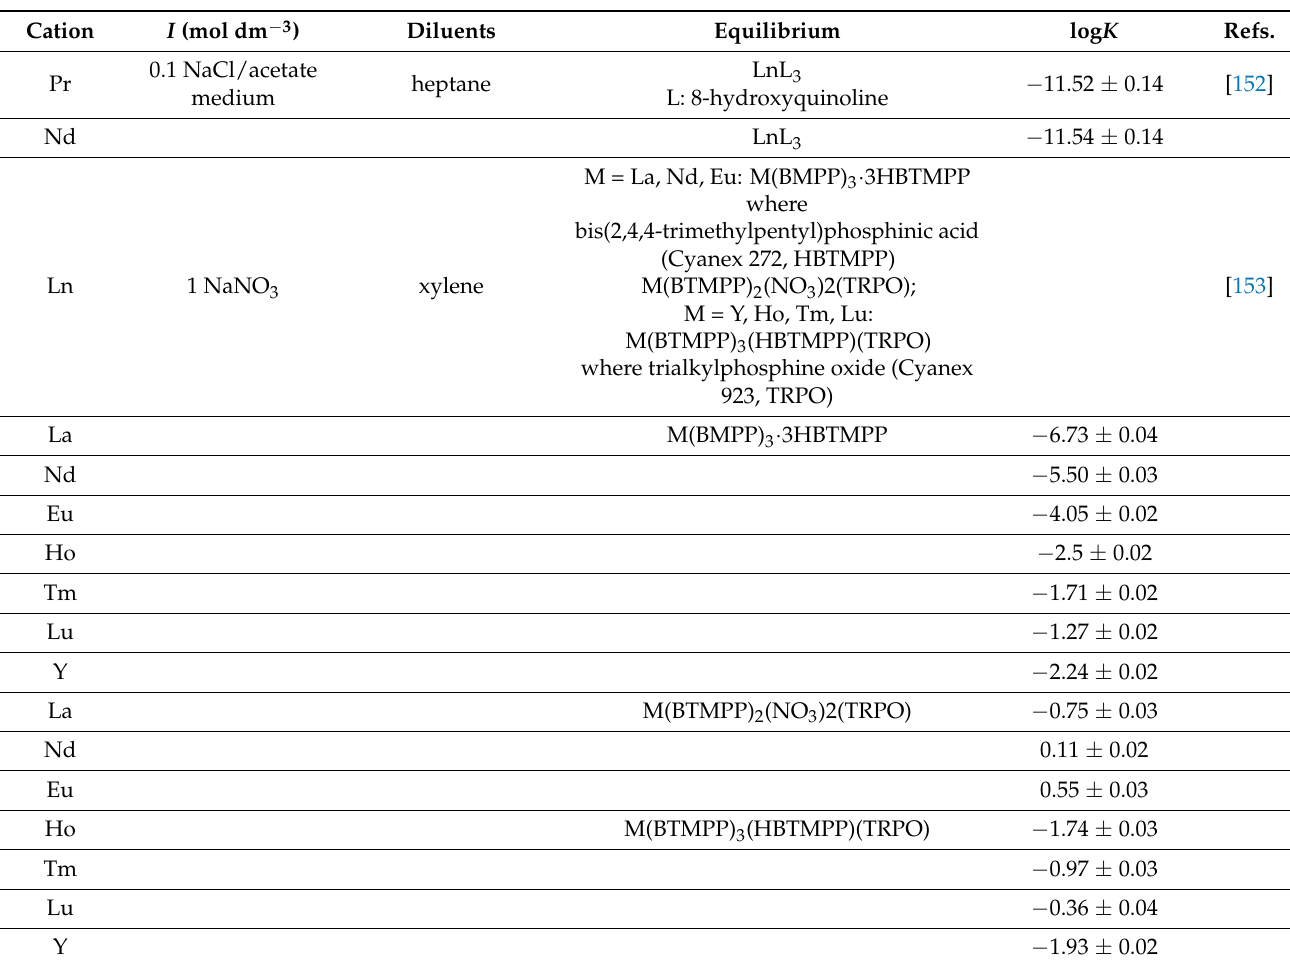
Table 8. Recommended data for the synergistic system of organic acid and organophosphorus